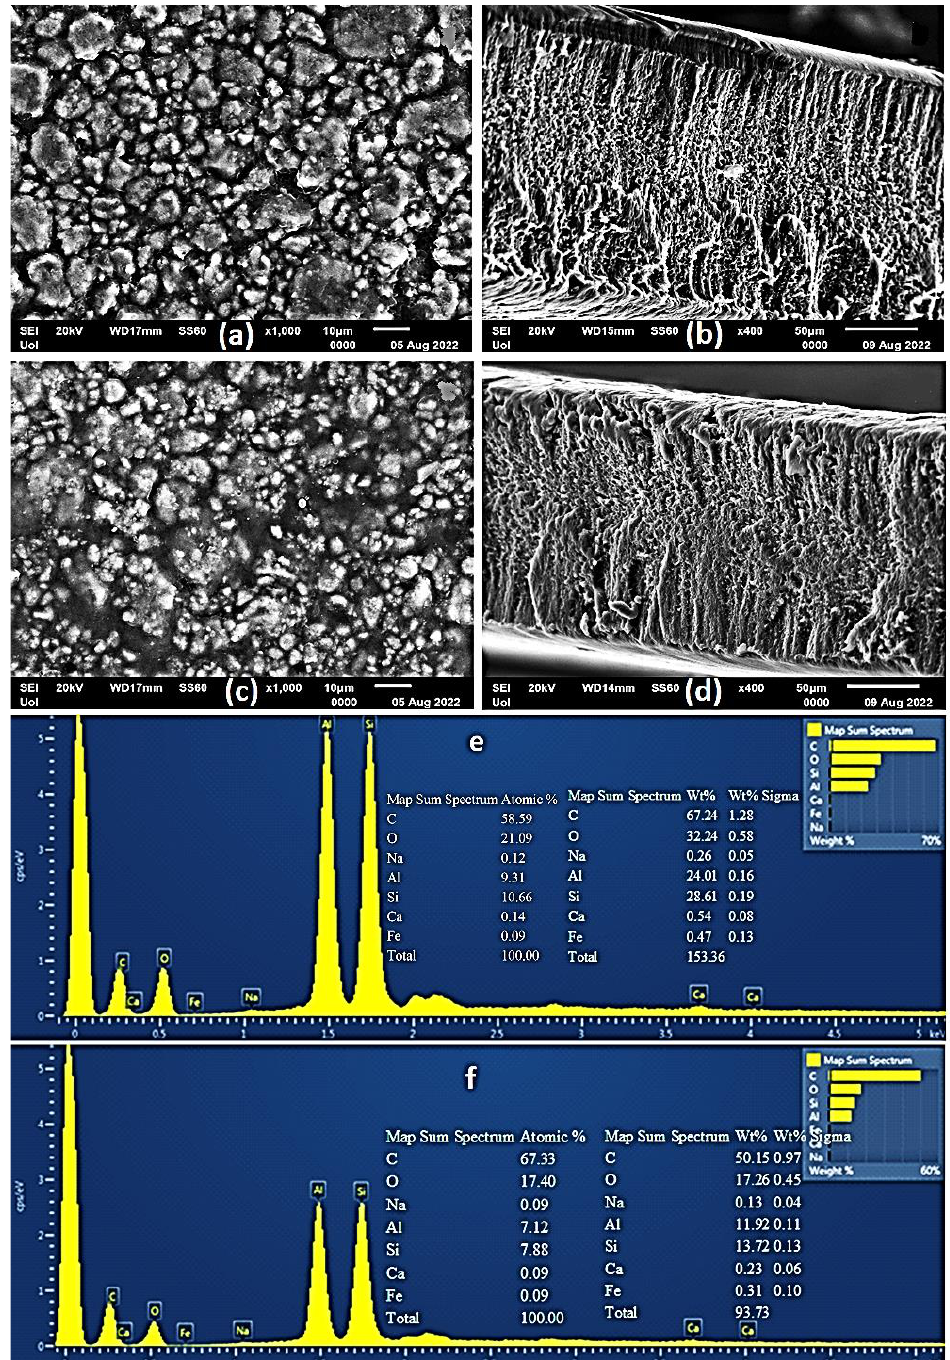
Figure 6. ( a , c ) SEM images of the surface and ( b , d ) cross-section for the nanocomposite films of ALG/G/10HNT ( a , b ) and ALG/G/10TO@HNT ( c , d ) respectively. ( e , f ) Energy dispersive spectrometer (EDS) spectrum and relative elemental analysis of the surface (inset) from the SEM images ( a , c ).